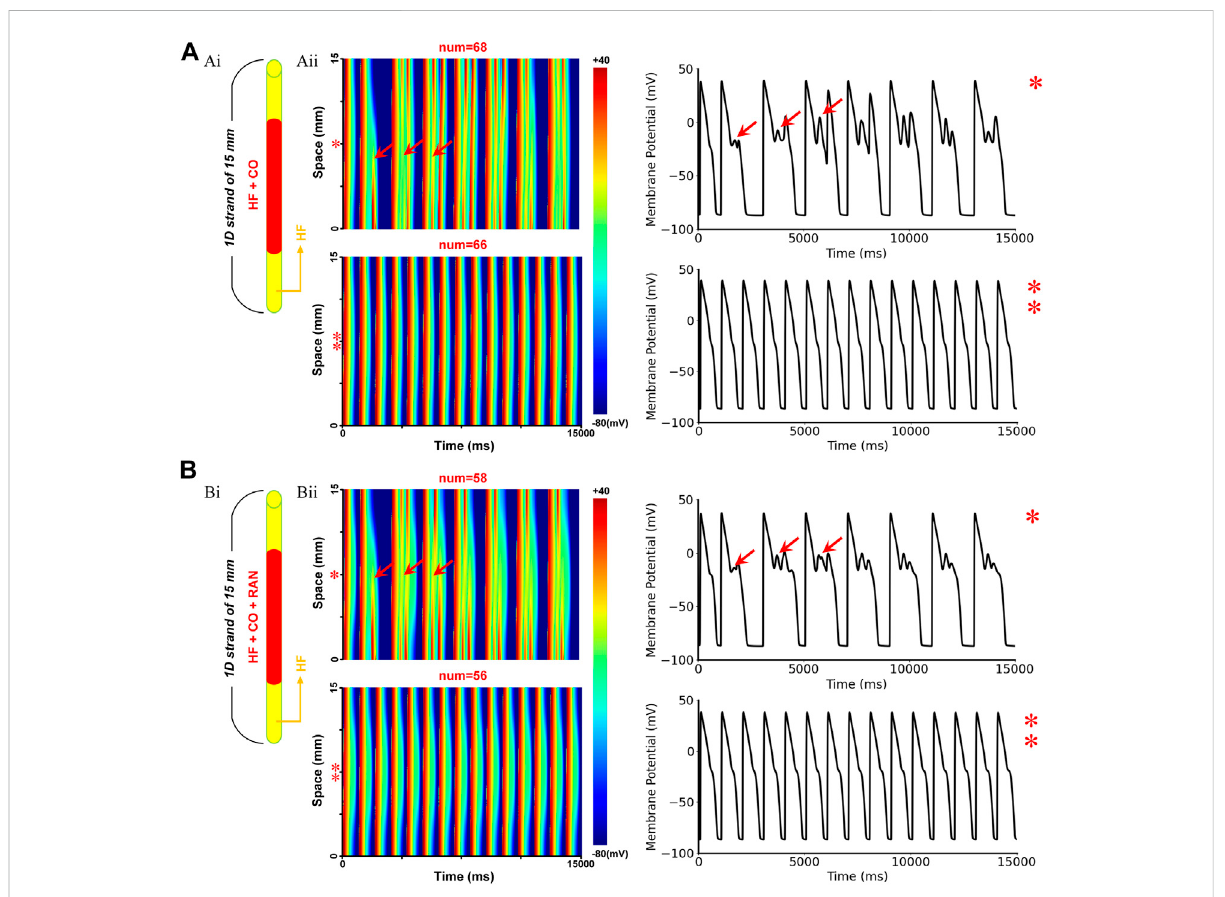
FIGURE 10 The criticalsize for initiating ectopicbeats in failing 1D homogenousventricular strands. (A) Simulatedeffects of CO on thefailing 1D tissue: (Ai) Schematicofthemodelinfected byCOregion,theredregion representsCO-affectedcells, whereas theyellowregionsatbothendsrepresent cells thatwerenotaffectedbyCO;(Aii)Schematicofthe1DexcitationwaveconductionintheCO-affectedtissuemodel(left)andthecorrespondingAPs of the cells marked ‘ * ’ or ‘ ** ’ (right). The red arrows ( ‘ ↑ ’ ) represent the location of ectopic beats and the corresponding EADs. (B) Simulation results under CO + ranolazine